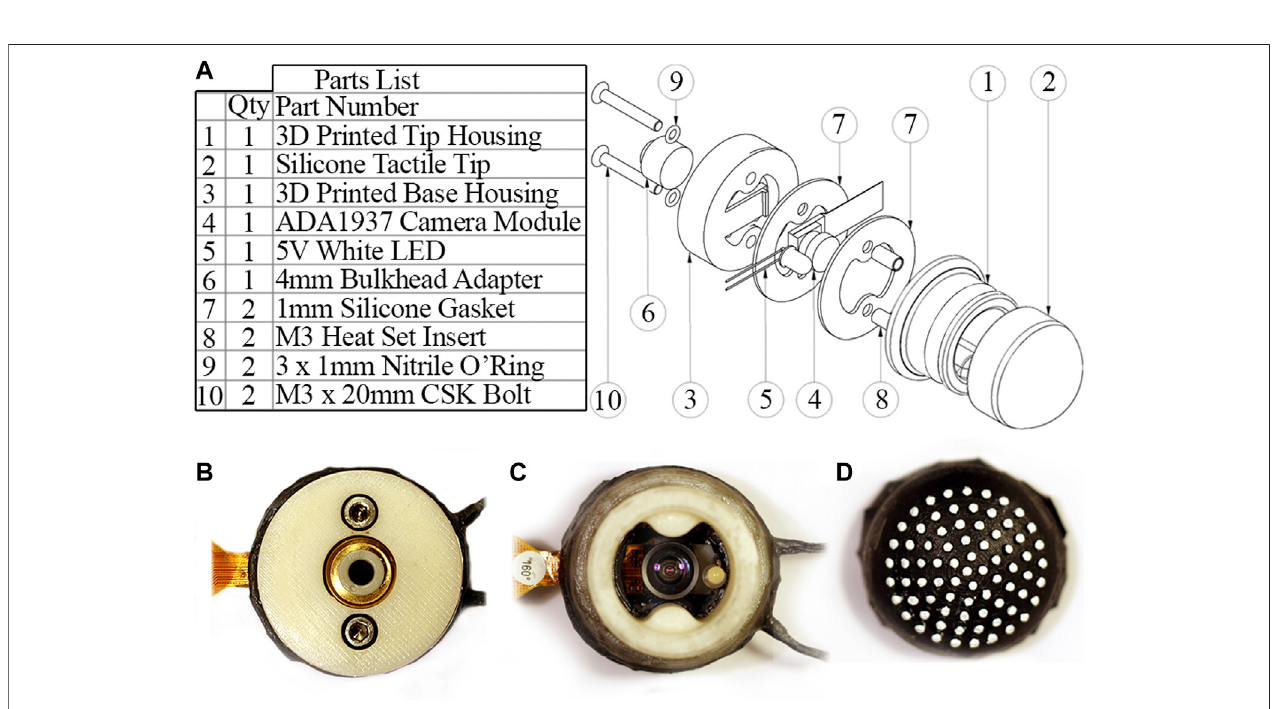
FIGURE 5 | (A) Part list and exploded view of the sensor housing assembly. (B) Sensor underside with bulkhead adapter for connecting pneumatic tubing. (C) Sensor internals with tactile membrane removed. (D) Inside of tactile membrane.